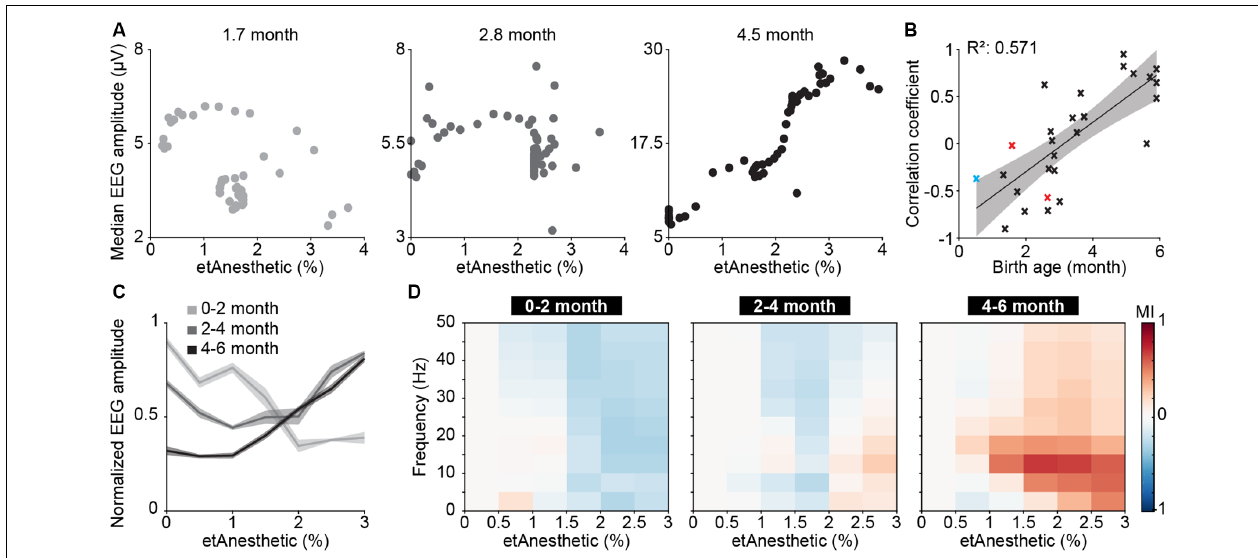
FIGURE 3 | Age-dependent switch from broadband suppression to frequency-specific effects of general anesthesia on electroencephalographic (EEG) activity in human neonates and infants. (A) Scatter plots displaying the median EEG amplitude as a function of anesthetic concentration for representative examples of 0–2, 2–4 and 4–6 months of age. (B) Scatter plot displaying the correlation coefficient of median EEG amplitude and anesthetic concentration in relation to birth age for sevoflurane (black), isoflurane (red), and desflurane (blue). (C) Line plots displaying normalized EEG amplitude as a function of anesthetic concentration. (D) Color-coded MI of median EEG amplitudes in different frequency bands as a function of anesthetic concentration for human babies of 0–2 months (left), 2–4 months (middle) and 4–6 months (right).